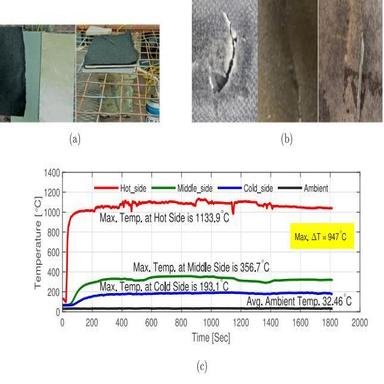
M12 — Fibreglass sheet (1 mm) + Mica laminate with wool (6 mm) + Graphite sheet (1.75 mm) (a) Before test, (b) After test, (c) Temperature plot.